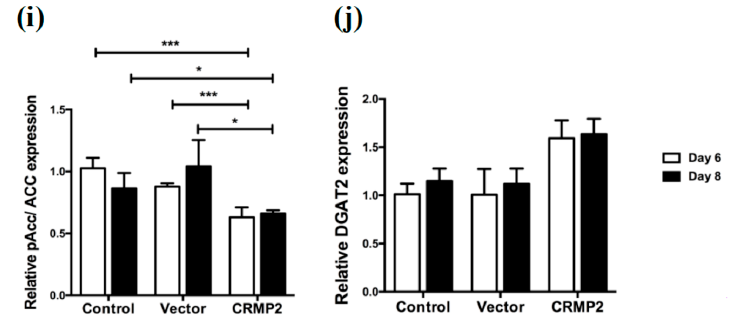
Figure 3. CRMP2 overexpression down-regulates the expression of critical adipogenic transcription factors and lipid-synthesizing enzymes. CRMP2-expressing or control vector were transfected into the cells on day 4 after entering differentiation. ( a ) Expression of CRMP2 was detected and quantified by immunofluorescence, scale bars = 20 μ m. ( b – j ) Levels of CRMP2, adipogenic marker proteins including PPAR γ , C/EBP α , GLUT4, and FABP4 and critical lipid-synthesizing enzymes on day 6 and 8 were analyzed by Western blotting, with actin as an internal control. Blue and red line at the right of panel ( b ) indicated proteins related to adipogenesis and lipid synthesis, respectively. The data were presented as the mean ± SEM, and statistically analyzed by one-tailed unpaired Student t- test ( n = 3). * p < 0.05; ** p < 0.01; *** p < 0.005.